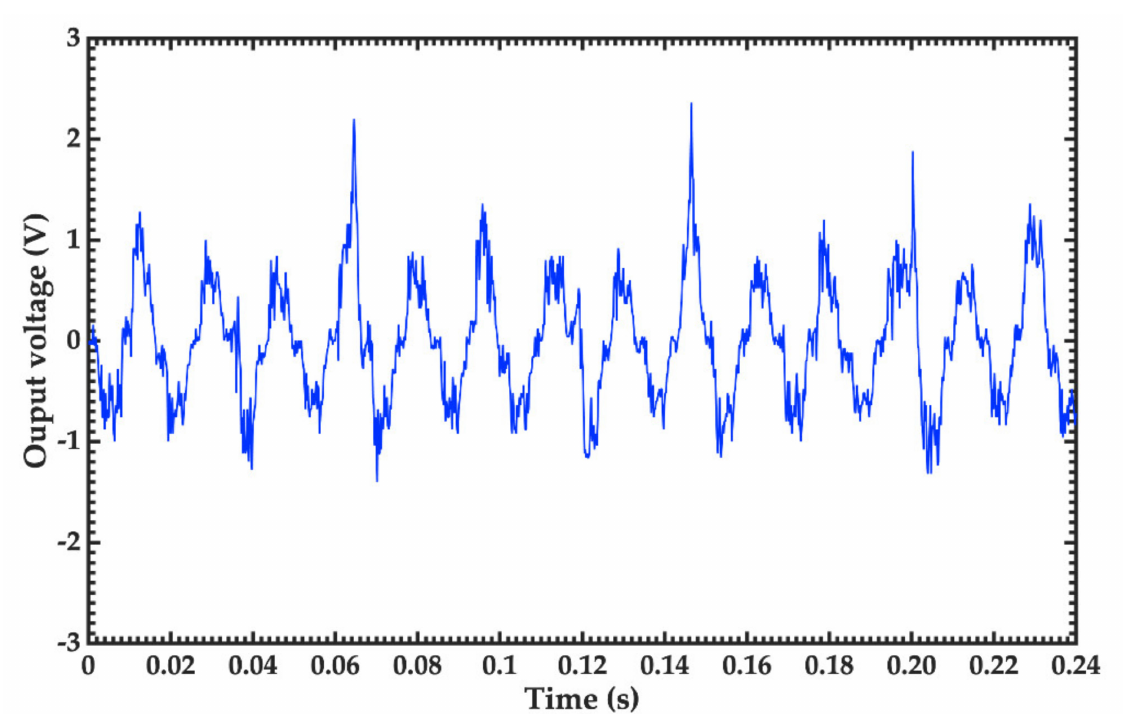
Figure 8. Measurements of the output voltage of the triboelectric energy harvester using a load resistance of 47 k Ω and a mechanical excitation at 59.7